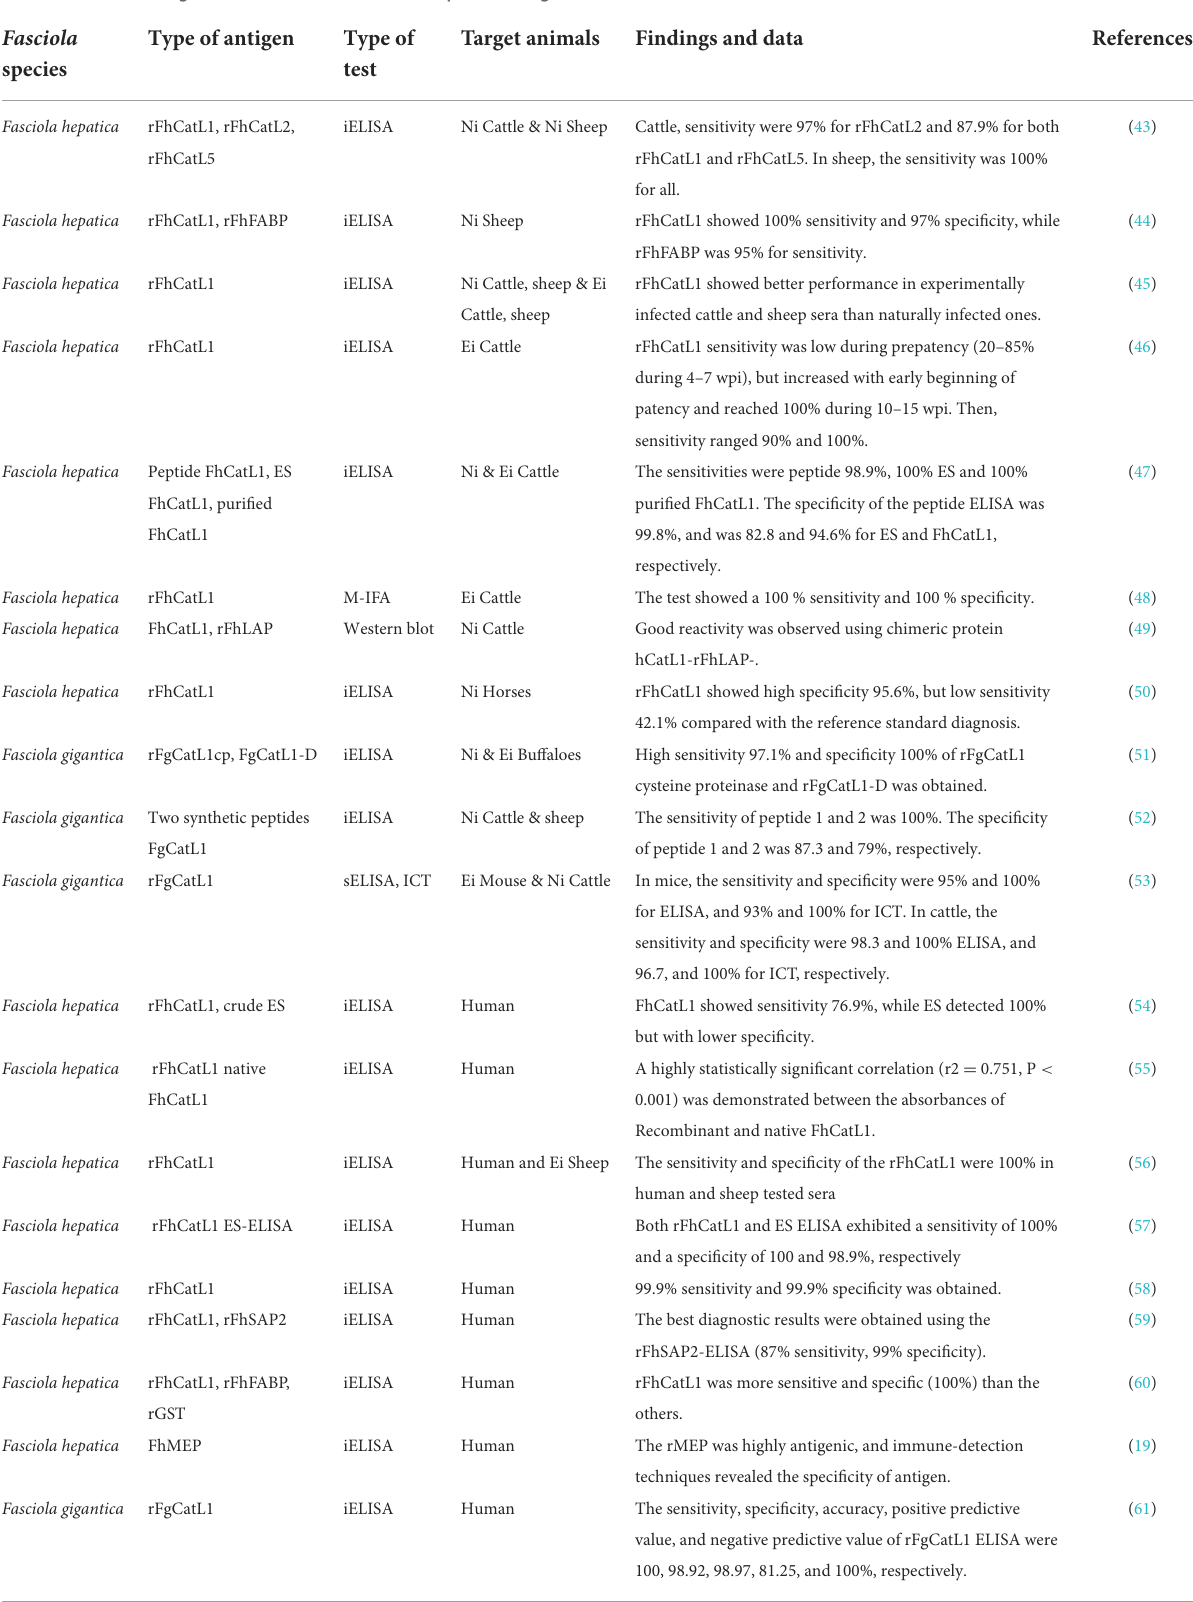
TABLE 2 Previous diagnostic studies on Fasciola cathepsin L1 antigen on different animal sera.